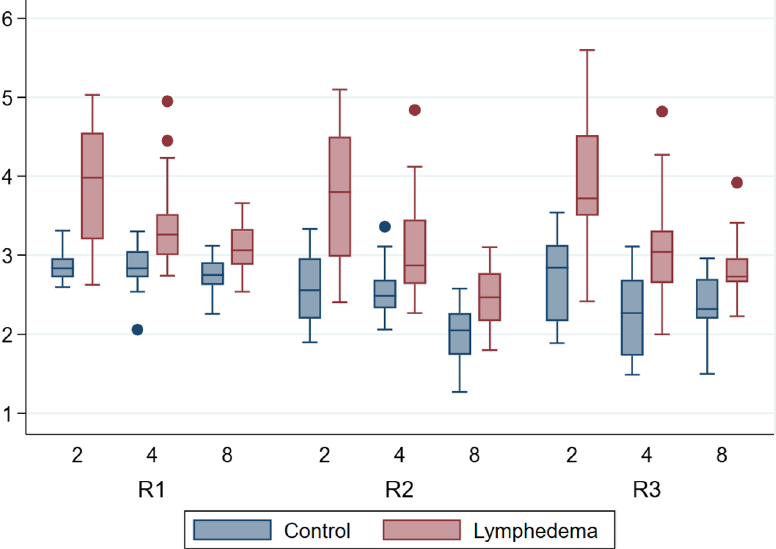
Figure 3. Descriptive boxplot showing electronic caliper [mm] by rater, week and group. The y-axis is in millimeters [mm]. The x-axis is weeks. R1 rater 1, R2 rater 2, R3 rater